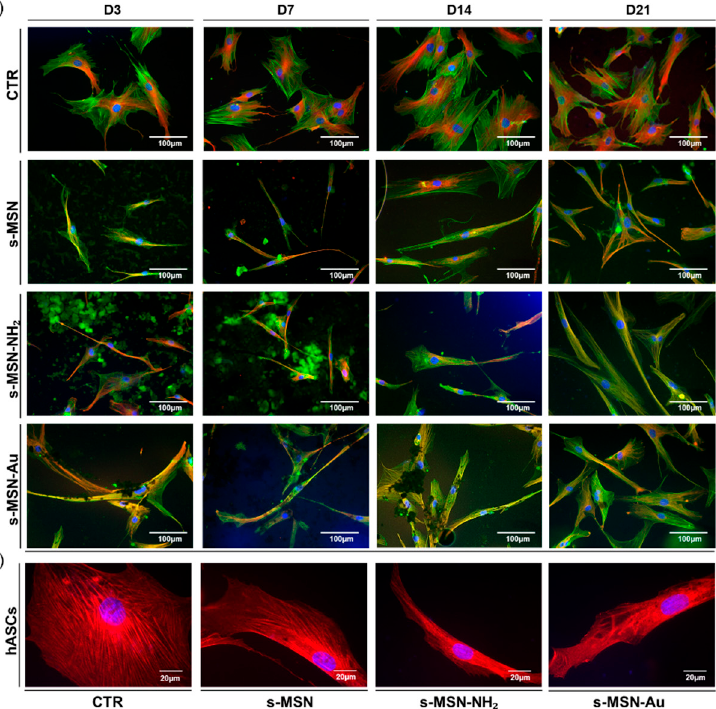
Figure 7. Long-term culture of hASCs morphology on CTR and s-MSN, s-MSN-NH 2 , and s-MSN-Au. ( a ) Representative images of F-Actin (Phalloidin-Alexa-fluor-488, GREEN), Microtubules (anti- β Tubulin antibody, RED), and Nuclei (DAPI, blue), Scale bar = 100 µm. ( b ) Representative images of expression of Filamin A (anti-Filamin antibody, RED), and nuclei (DAPI, blue) in stem cells on CTR and s-MSN, s-MSN-NH 2 , and s-MSN-Au. Scale bar = 20 µm.